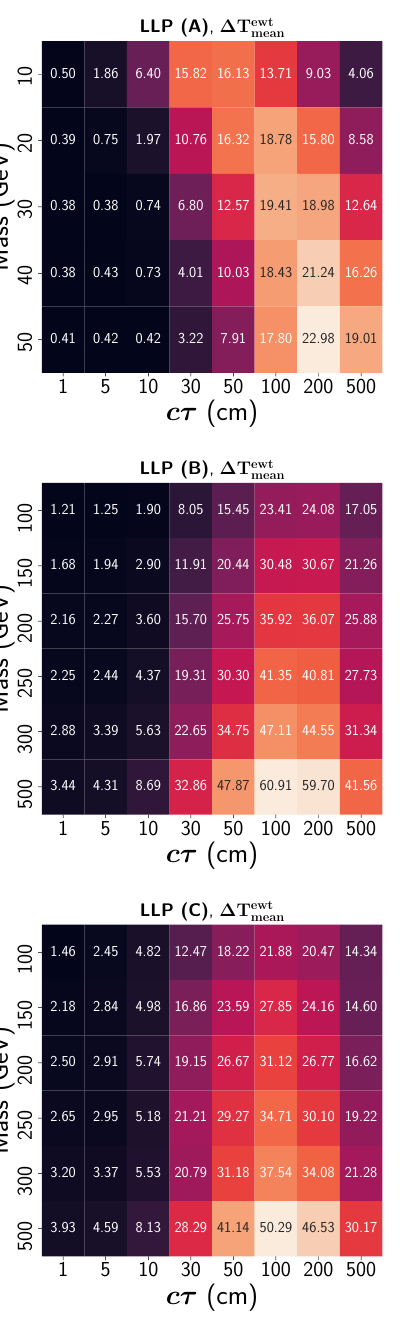
Figure 9 . Efficiency of selecting events for LLP scenarios (A) ( top ), (B) ( middle ) and (C) ( bottom ) in percent for various values of LLP mass and decay length using ∆ T Ewt ( right ). Efficiency is calculated by applying cuts on the jet p number of ECAL towers according to table 2 to keep the background rate ≈ 30